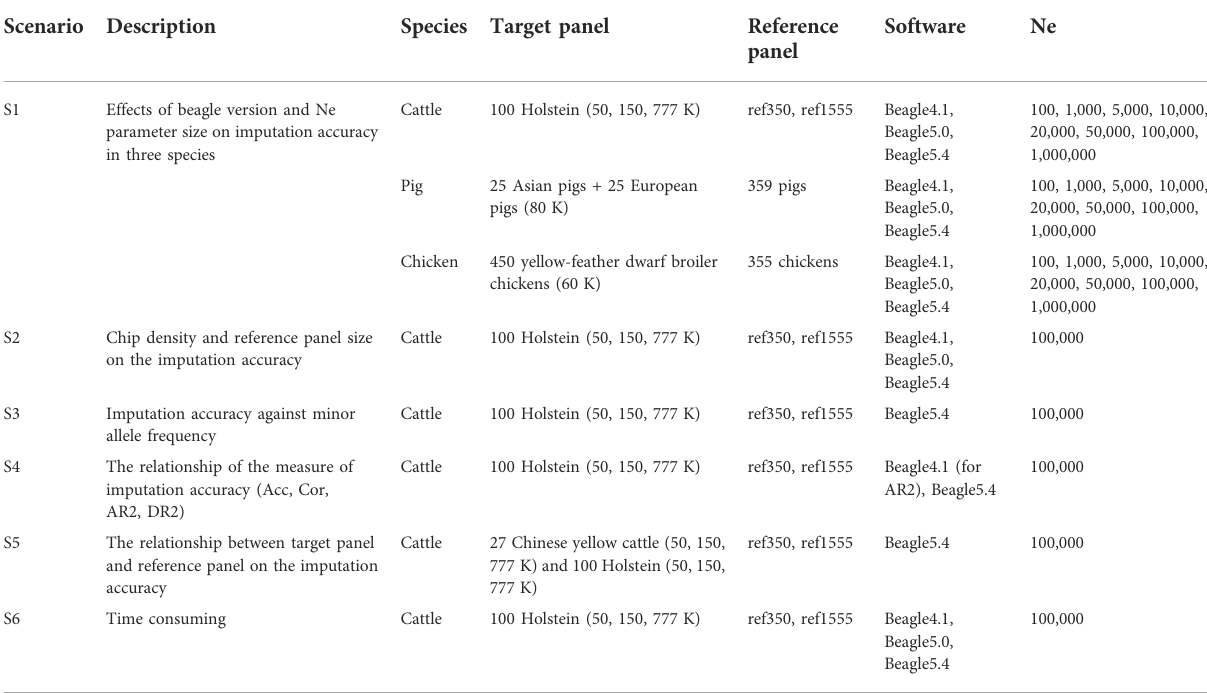
(Supplementary Table S2). Variants with a missing rate of more than 0.2, and a minimum allele frequency of less than 0.